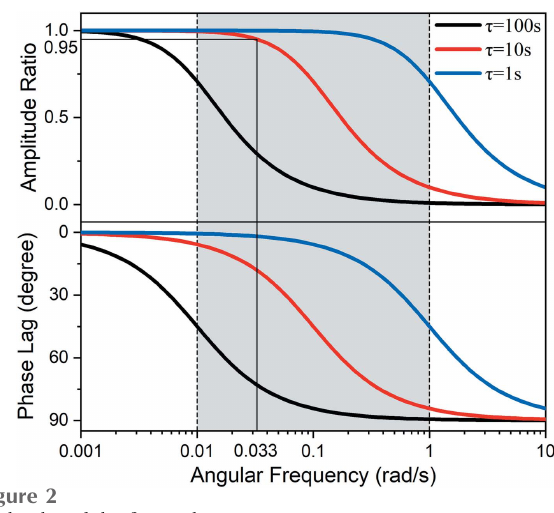
Figure 2 Bode plot of the first-order